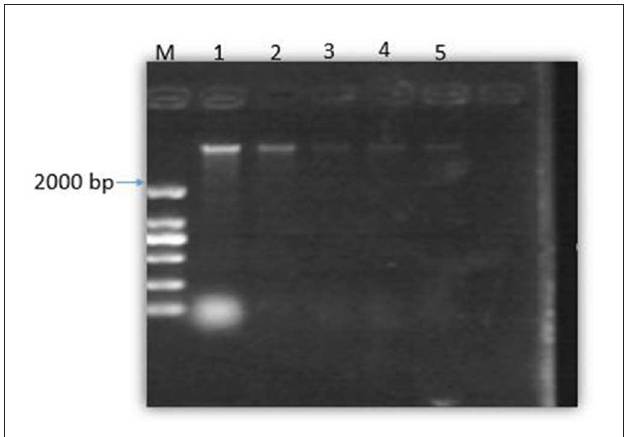
FIGURE7 Gel of bacterial DNA binding to SEDQS. M: Marker, 1: DNA untreated; 2: DNA treated with 1/4 MIC, 3: DNA treated with 1/2 MIC, 4: DNA treated with MIC, 5: DNA treated with 2 MIC.